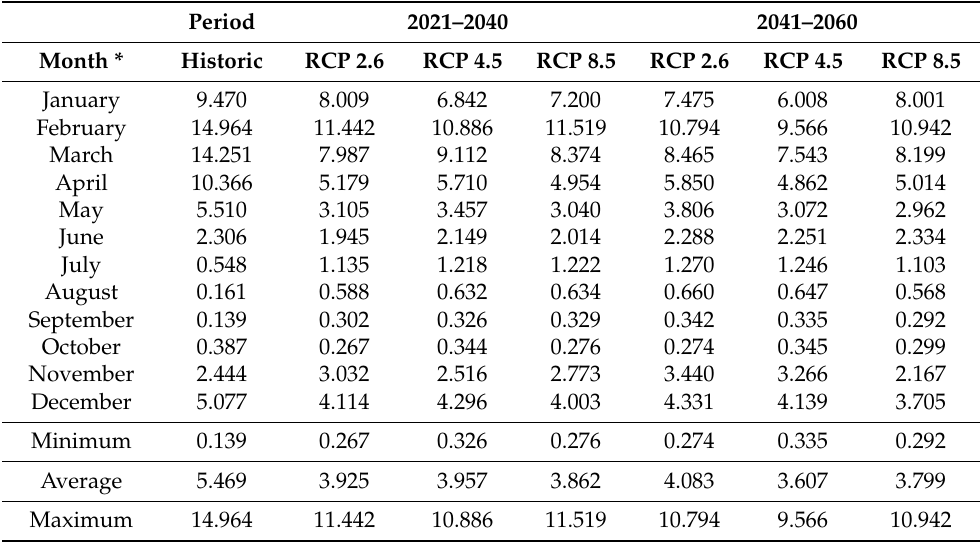
Figure 8. Average yearly discharge and average decrease in yearly precipitation (PCP) for the observed period 1998–2017 and SWAT simulated periods 2021–2040, 2041–2060, 2061–2080, and 2081–2100 under the influence of RCP 2.6, RCP 4.5, and RCP 8.5. Table 9. Average monthly observed flows (in m 3 /s) of El Kalb river during the historical period and average future simulated flows during the periods 2021–2040 and 2041–2061 and under RCP 2.6, RCP 4.5, and RCP